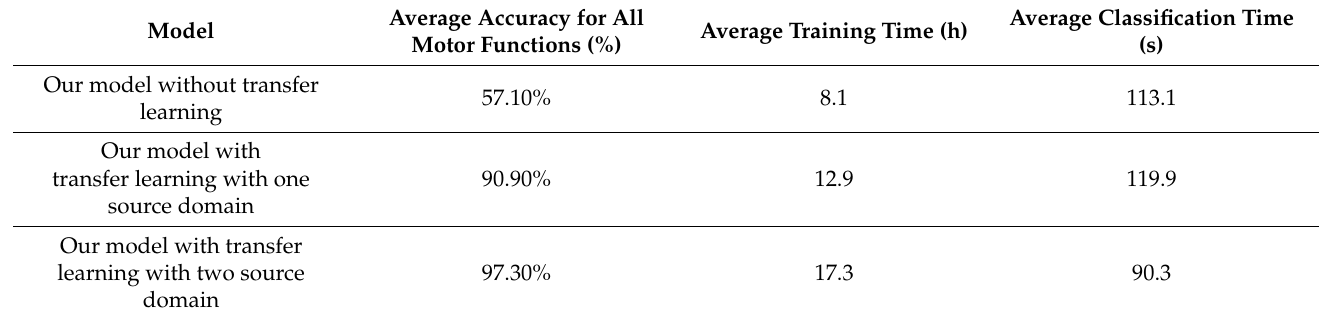
Table 12. Performance comparison of the proposed model with and without transfer learning.